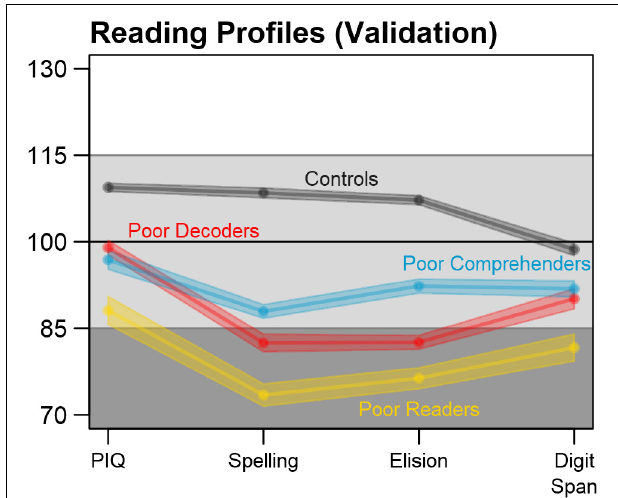
FIGURE 6 | Reading profile validation with independent measures. The reading profiles, including cases with imputed data, could be differentiated using additional test scores that were available in the multi-site dataset, but had too much missingness to be imputed and used for reading profile classification. Performance IQ = PIQ. Average test scores and SEM were calculated for each imputation, then pooled over the m = 10 imputed